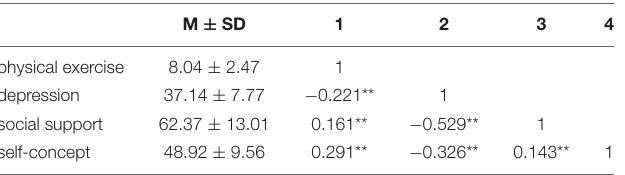
TABLE 1 | Pearson correlation analysis among different